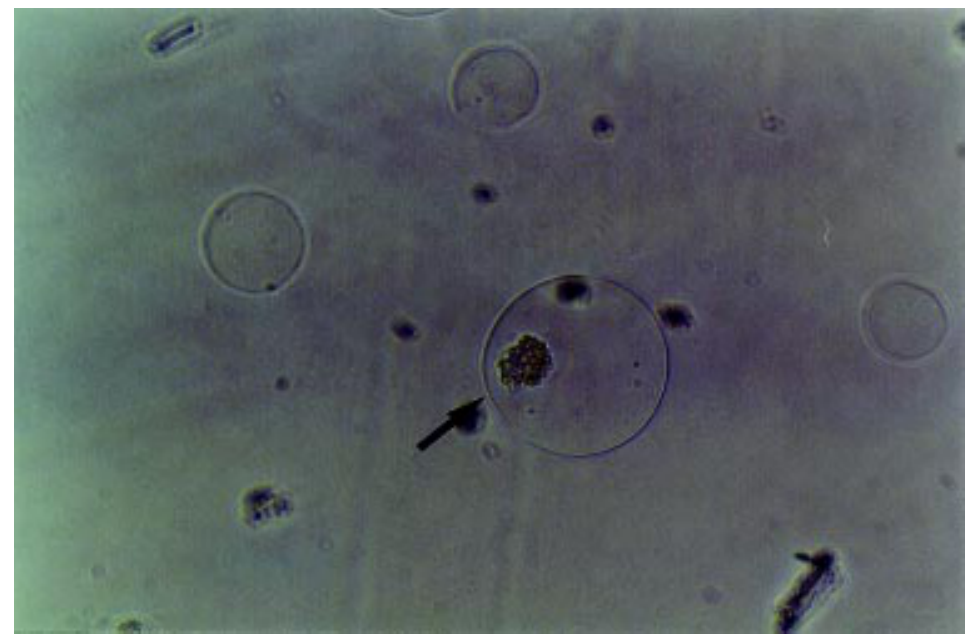
Figure 3. Biodritin capsule of 400 µm in diameter (arrow) con- taining a human pancreatic islet. Magnification